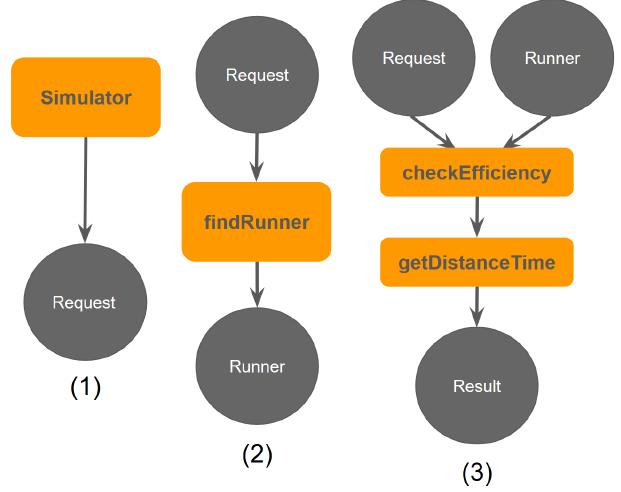
Figure 1. (1) The simulator generates a random request. (2) Processing by the delivery system to produce a carrier. (3) When the delivery is completed, efficiency metrics are computed [21] ©2020